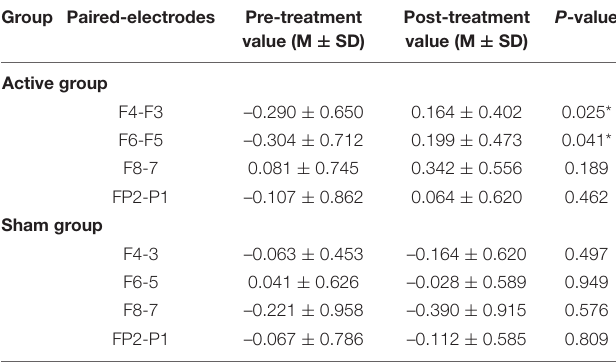
TABLE 4 | The asymmetry coefficients in different paired-electrodes before and after treatment in two groups. Group